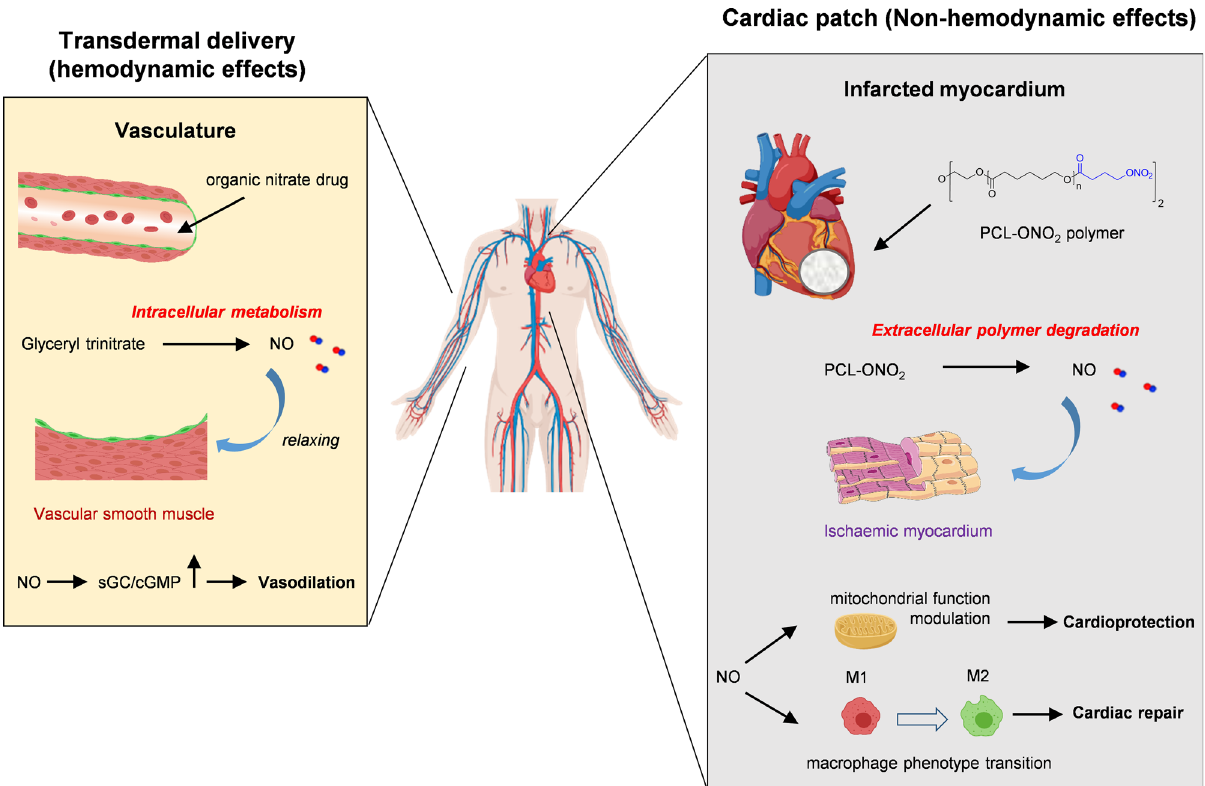
Fig. 10 Comparison of nitrate-functionalized cardiac patch with organic nitrates delivered by transdermal patch in terms of NO transformation pathway and therapeutic mechanism. Left: Organic nitrates administrated by transdermal patch or other routes often release into the vasculature rapidly and transform to NO through intravascular metabolism. Due to the short half-life of NO the therapeutics is mainly based on hemodynamic effects through dilation of vascular smooth muscle. Right: Compared to small molecular organic nitrates, local NO delivery by nitrate-functionalized patches can further provide non-hemodynamic effects on the ischemic myocardium, including cardioprotection and